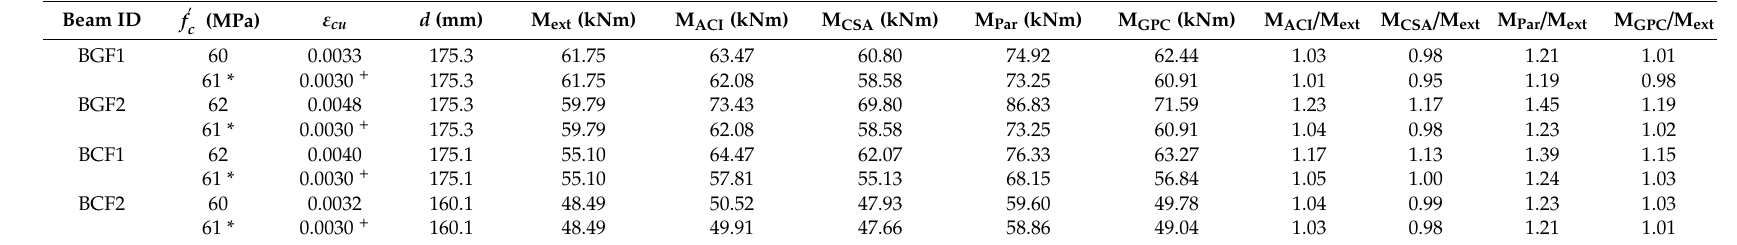
Table 8. Comparison of theoretical and experimental ultimate moment